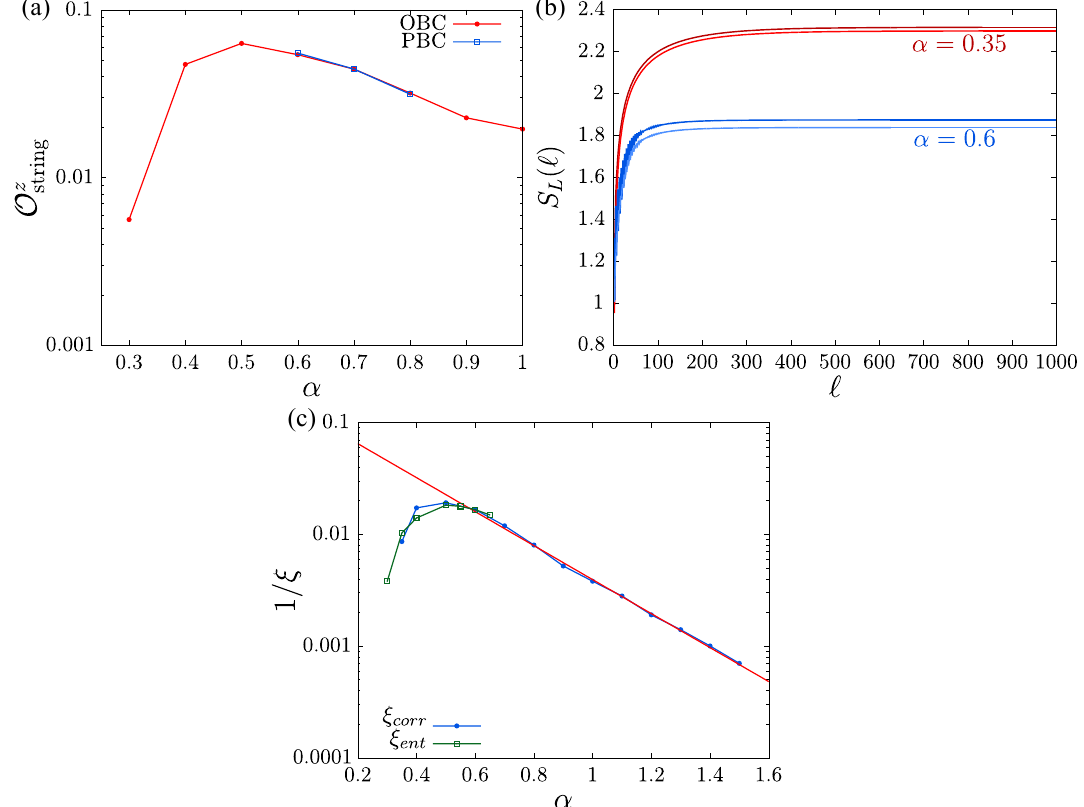
Figure 4: (a)String-order parameter as a function of α . Red (blue) line refers to open (periodic) boundary conditions. (b) Entanglement entropy as a function of the subsystem length l . (c) Inverse of the decay length estimated from the spin-spin correlation ( ξ ) and the entanglement entropy ( ξ ) as a function of α . Red line corr ent = 0.13exp ( − 0.35 α ) is a fit with the exponential function 1 /ξ corr